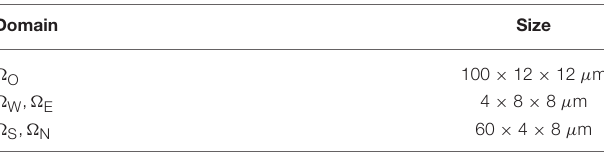
TABLE 6 | Cell sizes used in the simulations reported in Figures 7 – 9 and Tables 7 – 9 .